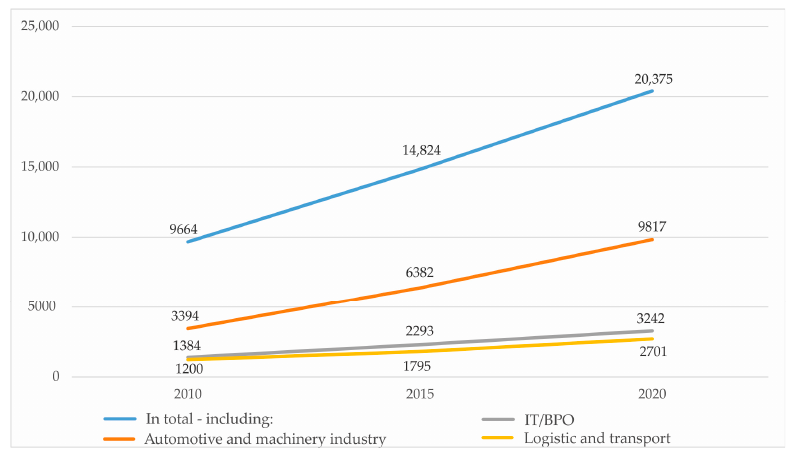
Figure 3. Changes in employment in selected priority industries in Lublin in 2010–2020.